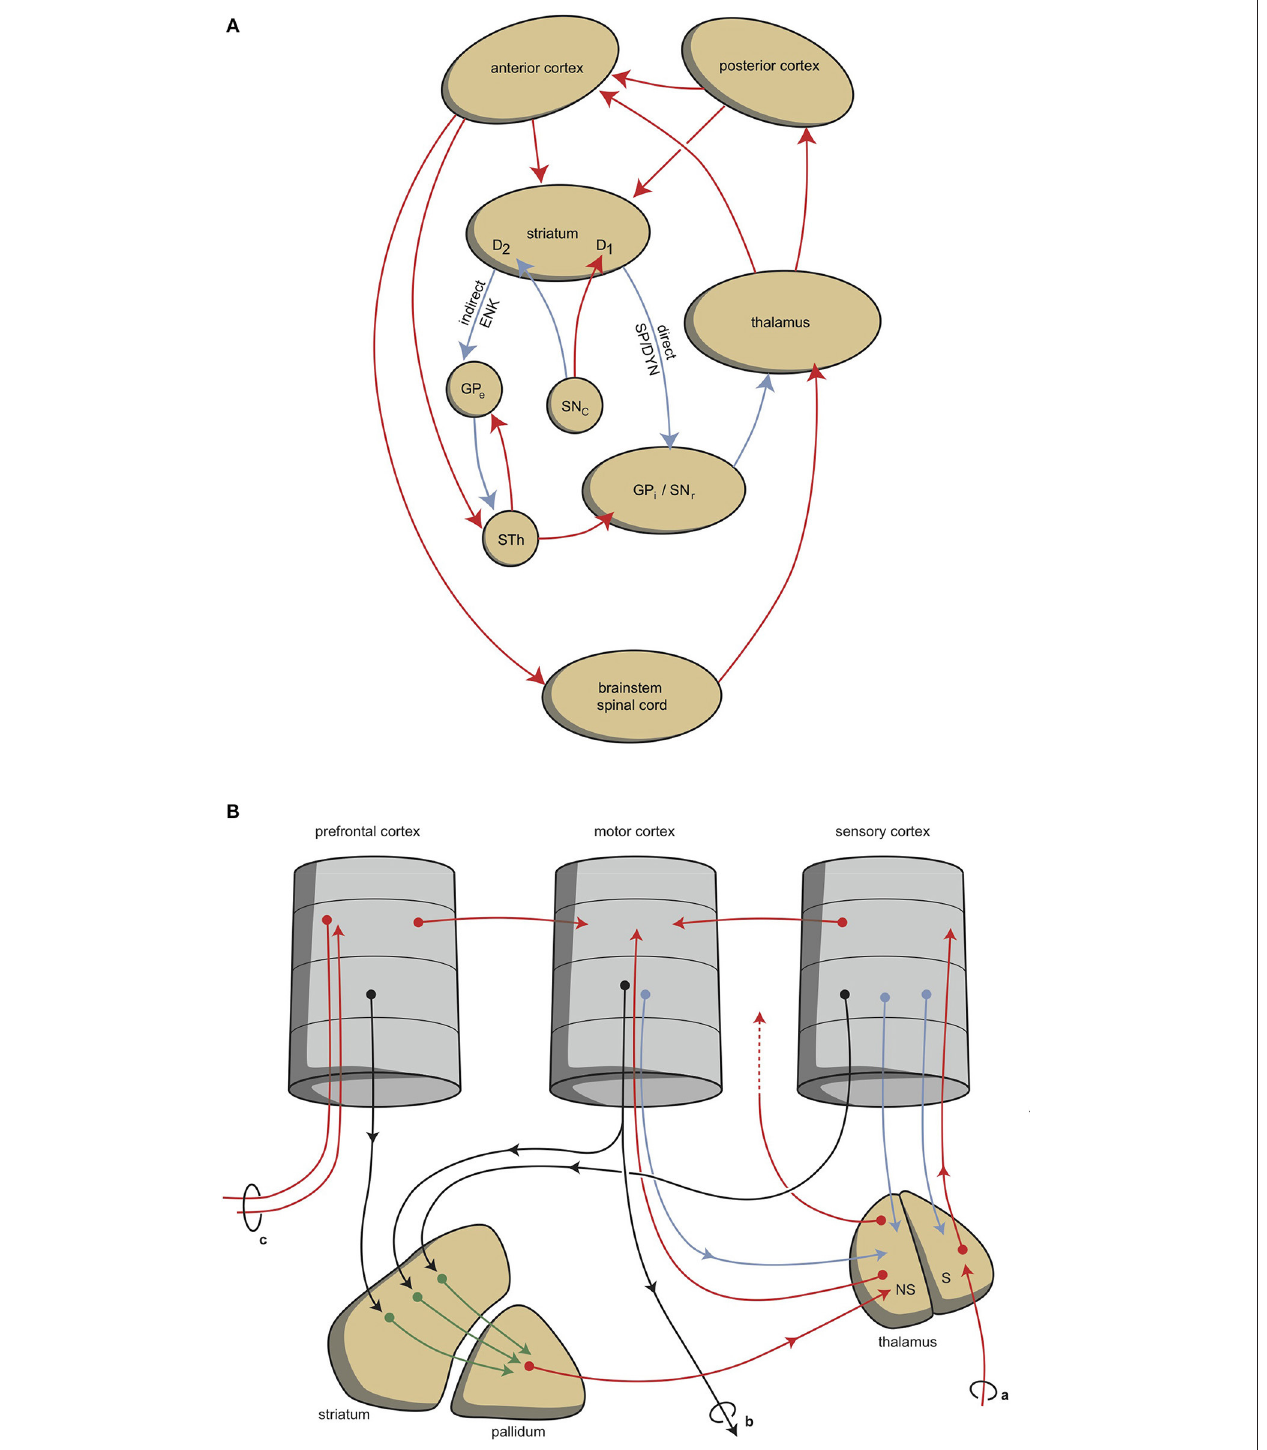
FIGURE 1 | Scheme representing the organization of human extrapyramidal system. (A) Direct and indirect pathways lead to the activation (red) or inhibition (blue) of the anterior cortical endpoint. D1, medium spiny neurons carrying dopamine D1 receptors; D2, medium spiny neurons carrying dopamine D2 receptors; DYN, dynorphin; ENK, enkephalin; GPe, globus pallidus externa; GPi, globus pallidus interna; SP, substance P; STh, subthalamic nucleus. (B) Convergent pathways via the basal ganglia correct the serially connected intracortical connections. a, sensory input; b, motor output; c, to contralateral cortex; NS, non-specific part of the thalamus; S, specific part of the thalamus. Red, black, green, and blue arrows = neurochemically undetermined.